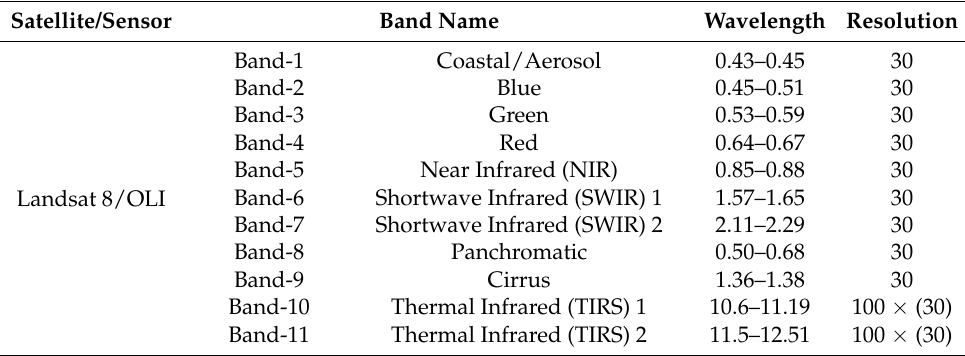
Table 1. Details of Landsat 8 satellite